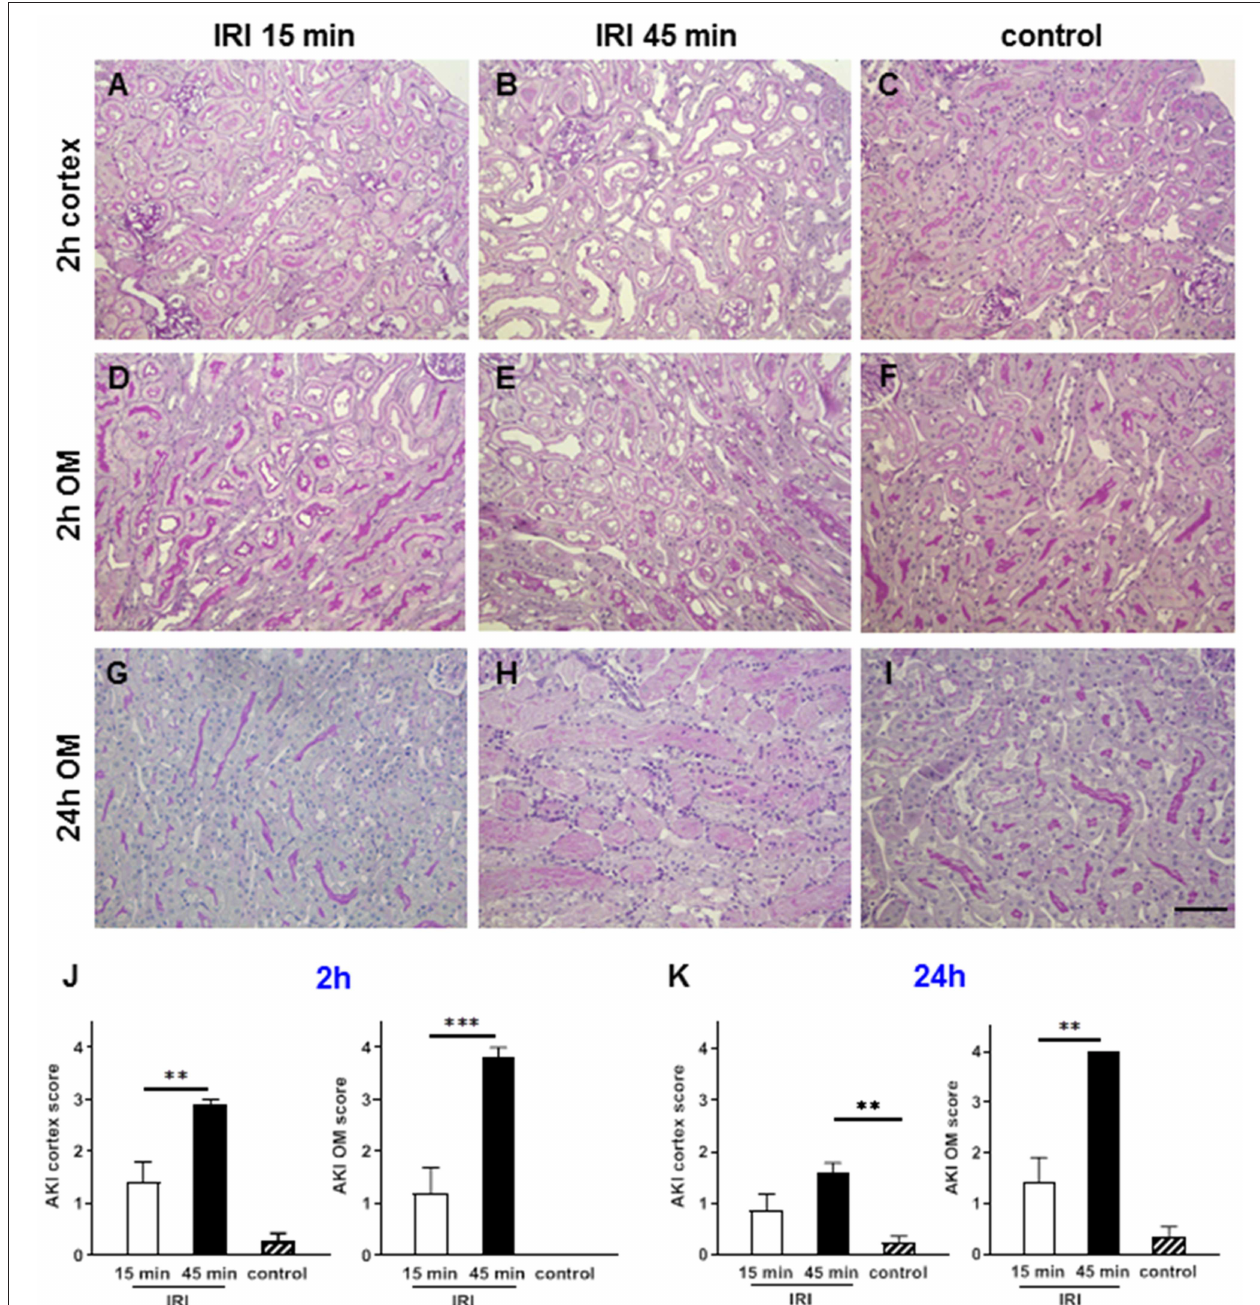
FIGURE 3 | Renal morphology at two and 24h after IRI. PAS staining revealed that mild AKI was present already after 2h in short term IRI (15min, A,D,G,J ). Longer ischemia time of 45min caused more severe AKI mainly in the outer medulla (B,E,H,K) . Sham kidneys served as controls and showed normal renal morphology (C,F,I) . Signs of AKI were less at 24h after IRI in this short IRI group and more pronounced in the prolonged IRI group ( G–I , mean ± SEM, ** p < 0.01, *** p < 0.001, bar: 100 µ m, n = 6 mice/group, one way ANOVA).